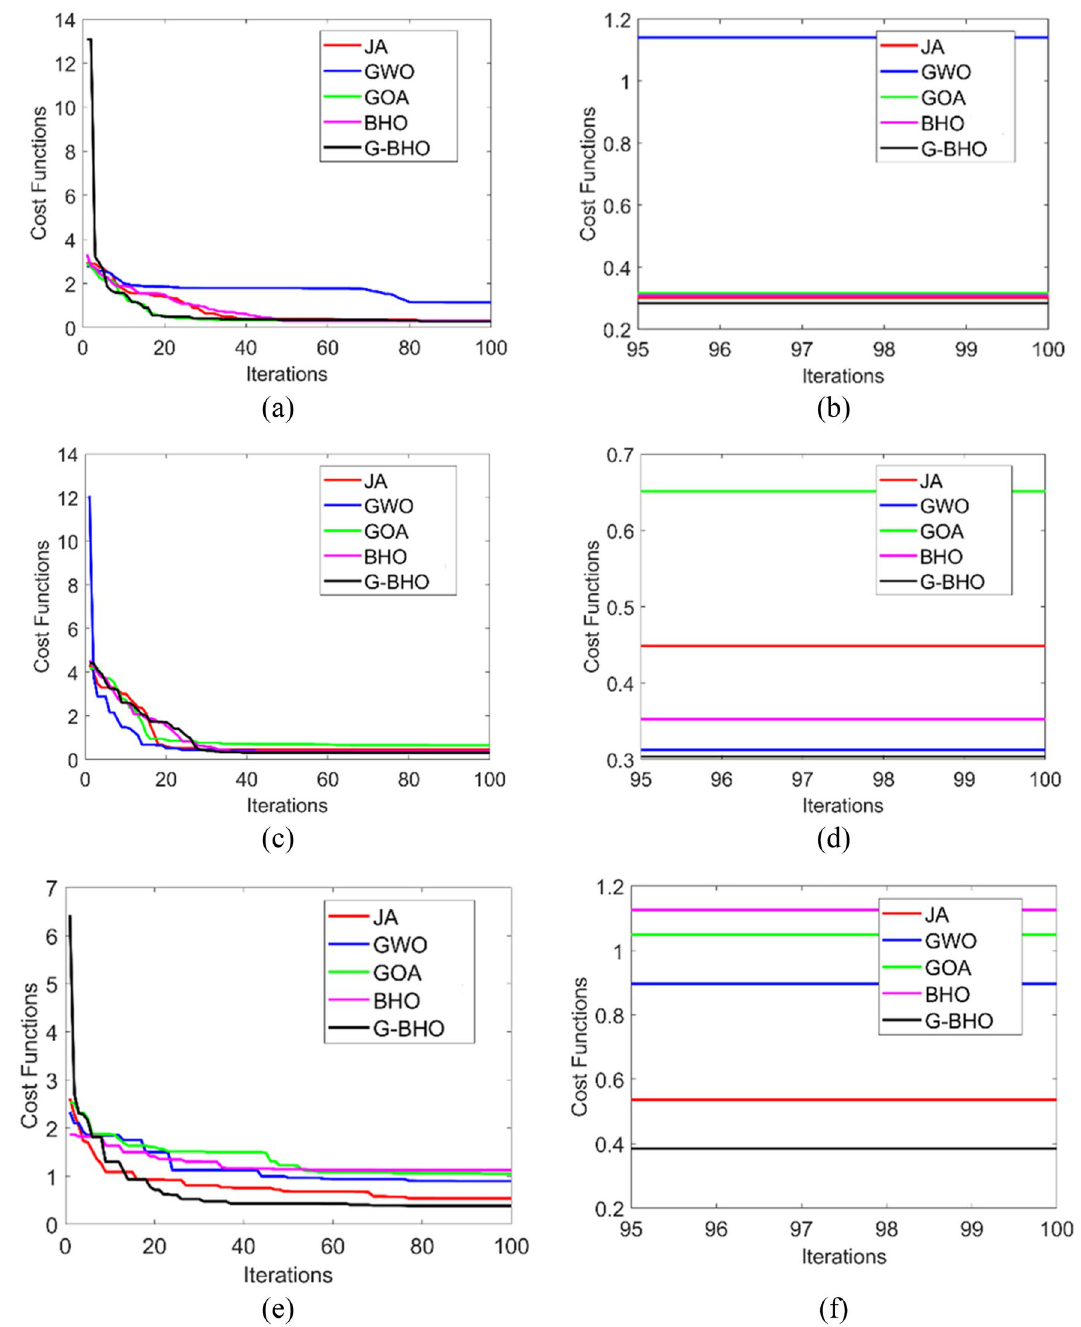
Figure 6. Convergence analysis of the designed intelligent privacy preservation model using ( a ) Test case 1, ( b ) Zoom in of ( a ), ( c ) Test case 2, ( d ) zoom in of ( c ), ( e ) Test case 3, and ( f ) zoom in of ( e